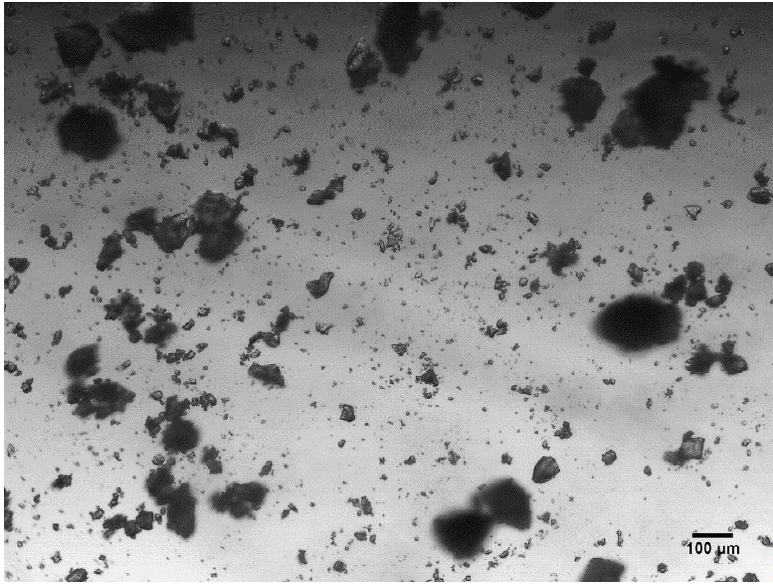
Figure 4. Optical microscope images of finely ground bulk monolith particles below 150 μ m in size.